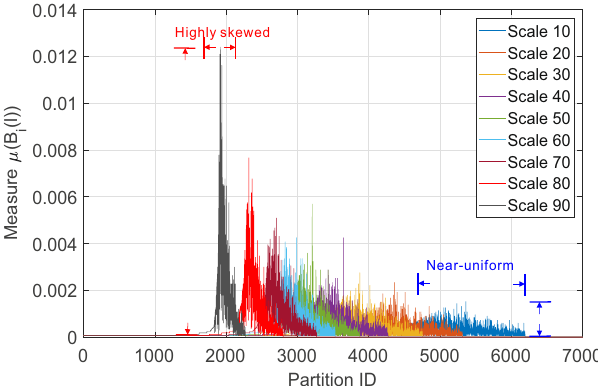
Figure 11. Distribution of probability measure as a function of scale of multi-fractal analysis on collaboration